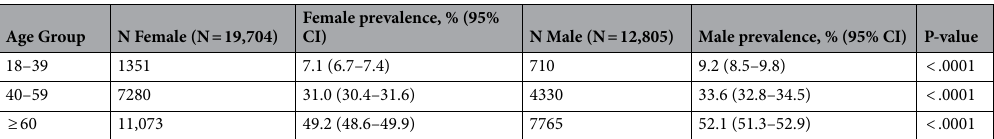
Age Group N Female (N = 19,704)